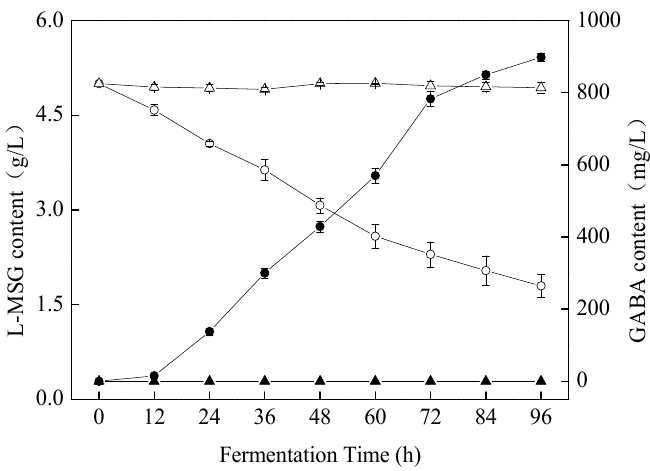
Figure 5. L-MSG and GABA content changes over 96 h. The and △ indicate L-MSG content in the